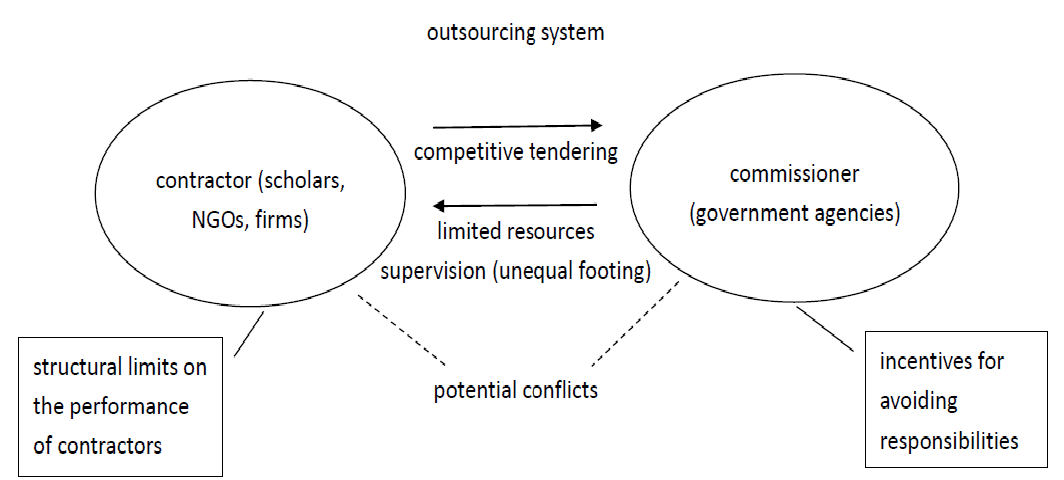
Figure 2 The outsourcing system as a mechanism for “defanging”